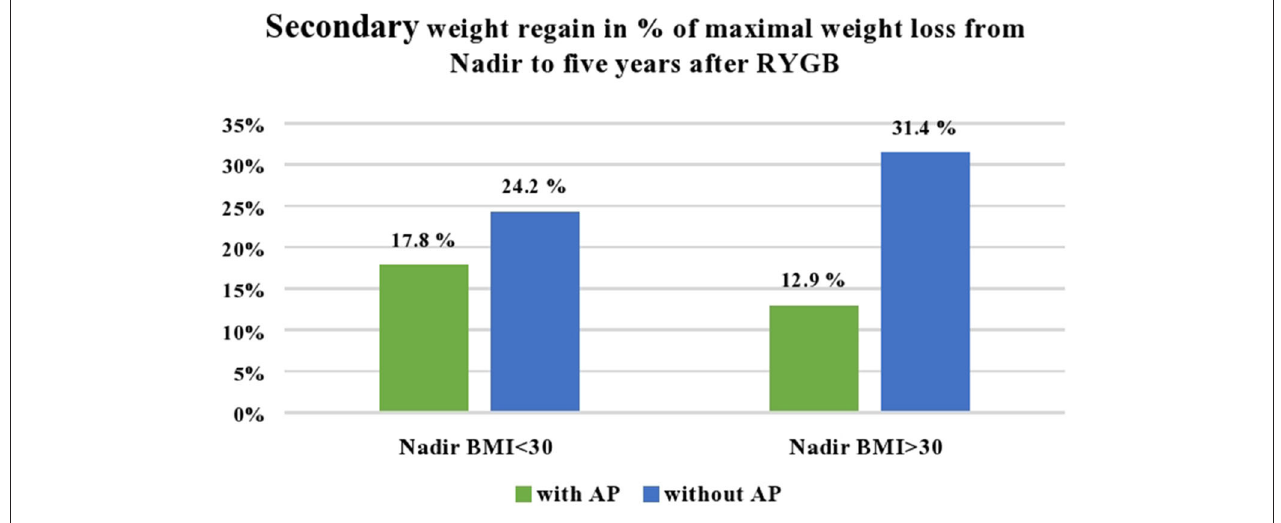
FIGURE 3 | Changes in mean BMI from baseline until 5 years after RYGB in men and women with and without abdominoplasty.